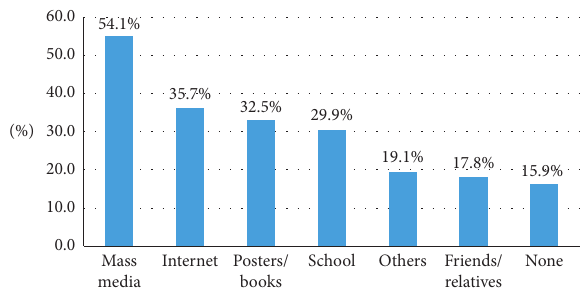
Figure 1: Source of BLS information reported by secondary school students in Abha City, southern Saudi